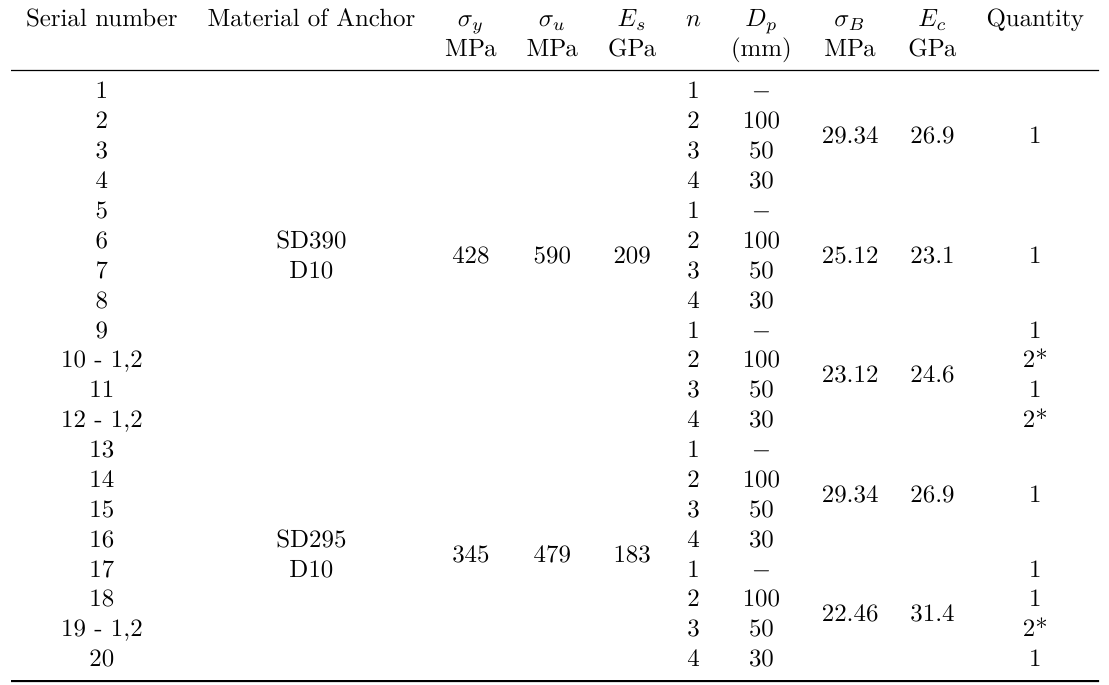
Table 1. Properties of